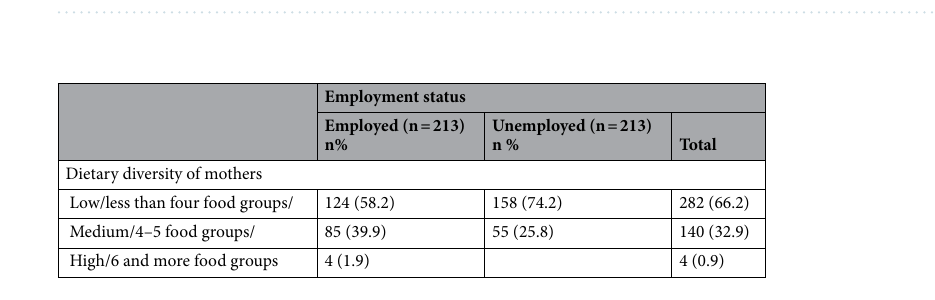
Table 3. Dietary diversity of employed and unemployed mother at Debre-tabor town, Northwest Ethiopia,